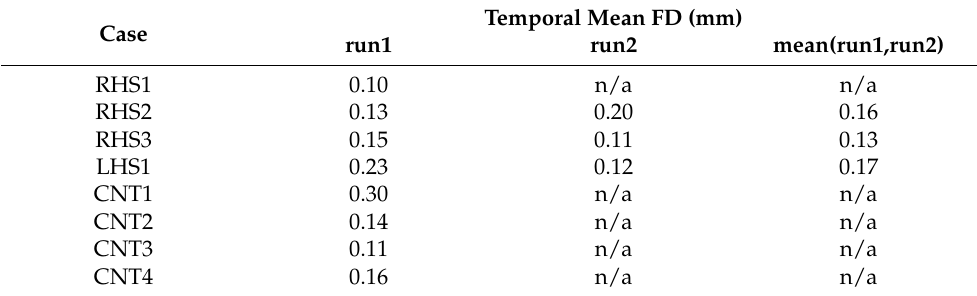
Table 2. Head motion per subject. Temporal mean framewise displacement (FD) in millimeter per case and run, as well as mean over runs, where